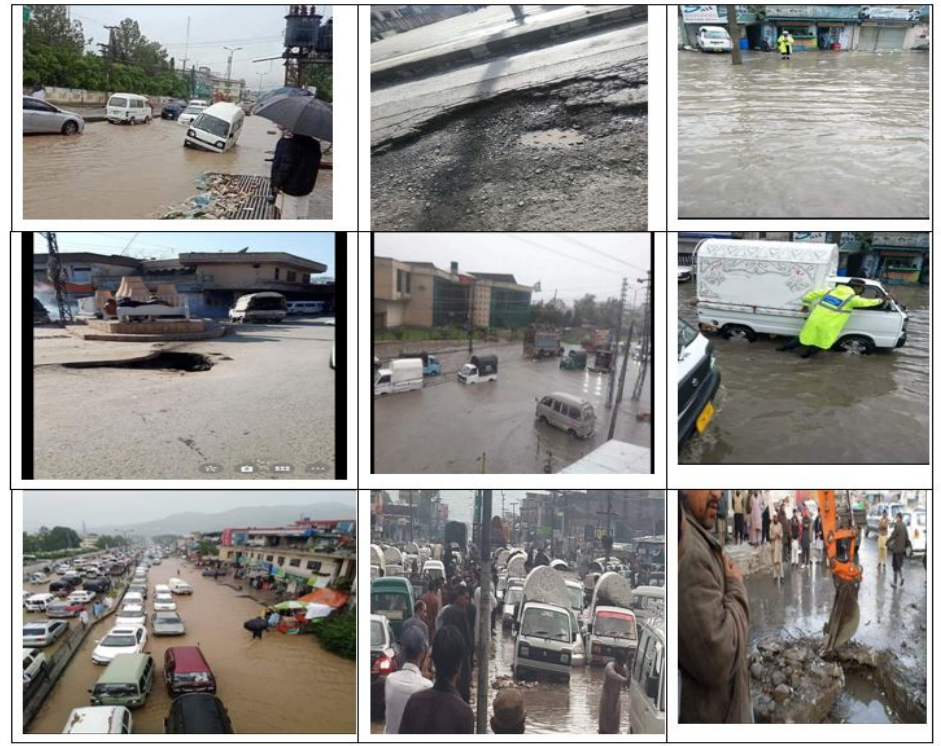
Figure 15. Water on the main road (KKH) during raining.